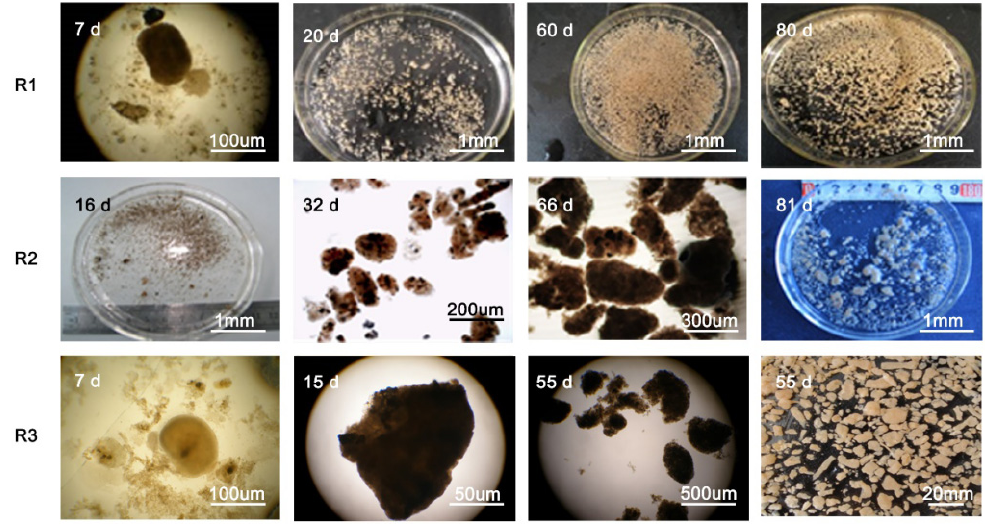
Figure 6. The image analysis of aerobic granules in the formation process in R1, R2, and R3. The SEM observations of the matured aerobic granules in R1, R2, and R3 are shown in Figure 7. The granular sludge in R1 had a clear ellipsoid outer surface, and there is a certain amount of void structure for oxygen and organic matter transmission. The particle surface is mainly occupied by Cocci and Brevibacterium. On the surface of granular sludge in R2, the EPS was observed, which makes Cocci and Brevibacterium on the surface granular sludge closely bonded together. Compared with granular sludge in R1, the structure in R2 was more compact. This dense flora arrangement structure gave sludge good settling capability, biological activity, and impact resistance. The granular sludge in R3 was mainly composed of filamentous bacteria, which formed a loose granular sludge skeleton.